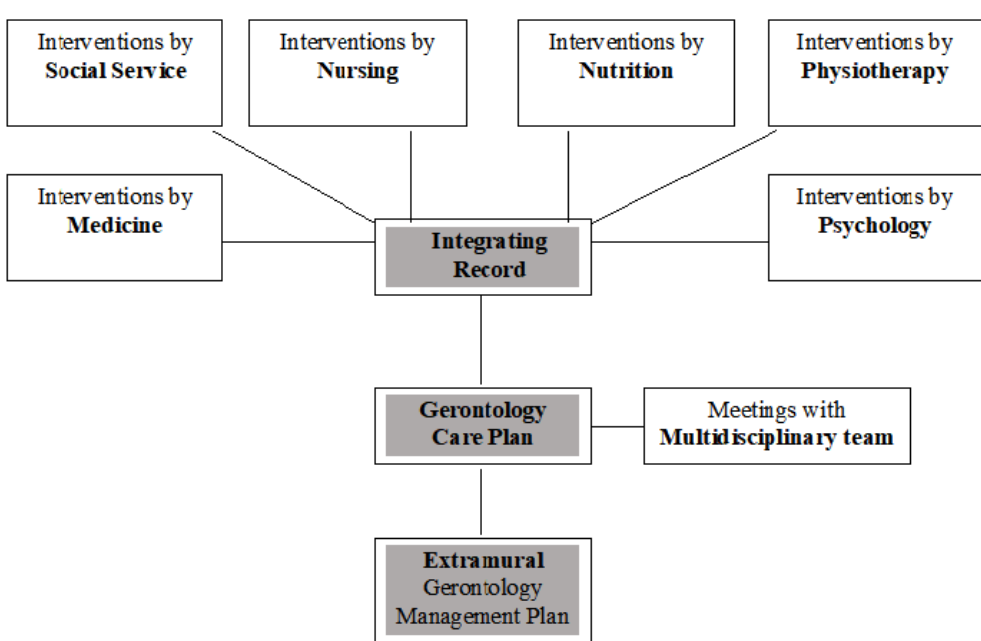
Figure 1. Integrating Record of Care interventions and referrals to Care Management for Elderly within Geriatric Services of a Tertiary Hospital, São Paulo,